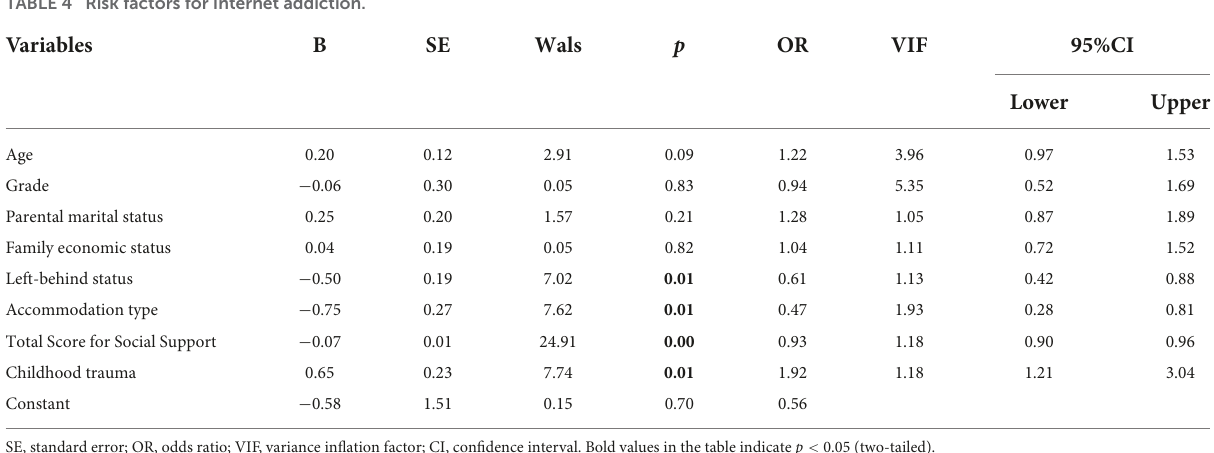
TABLE 4 Risk factors for Internet addiction.